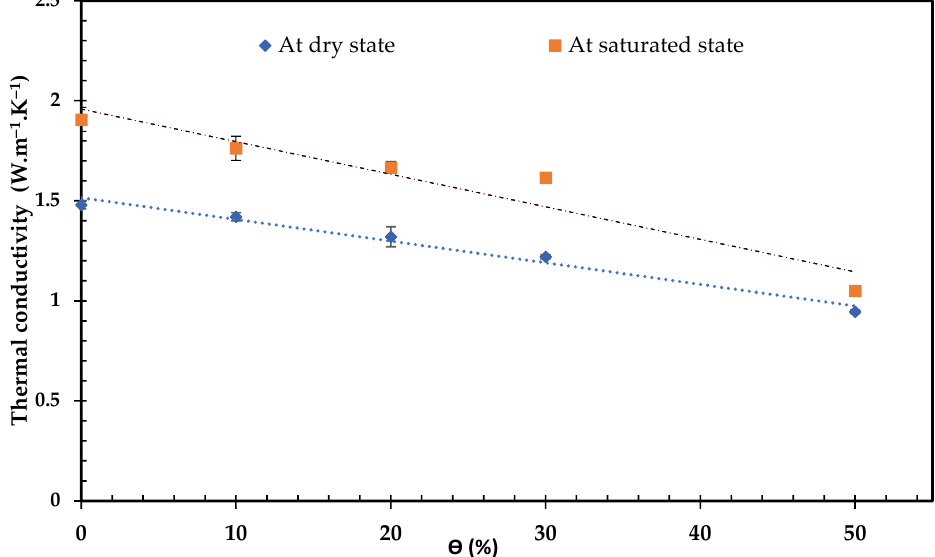
Figure 15. Thermal conductivity variation of concrete incorporated with different volume rates of RWG, at dry and saturated states.